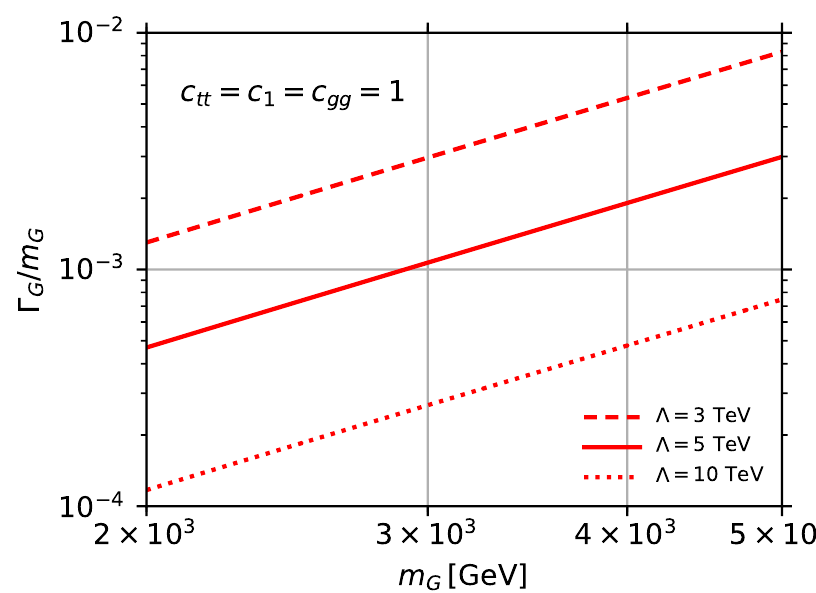
Figure 5 . Total width of the KK graviton to its mass as a function of the KK graviton mass, where c tt = c 1 = c gg = 1 with (cid:3) = 3 (dashed), 5 (solid) and 10 (dotted)